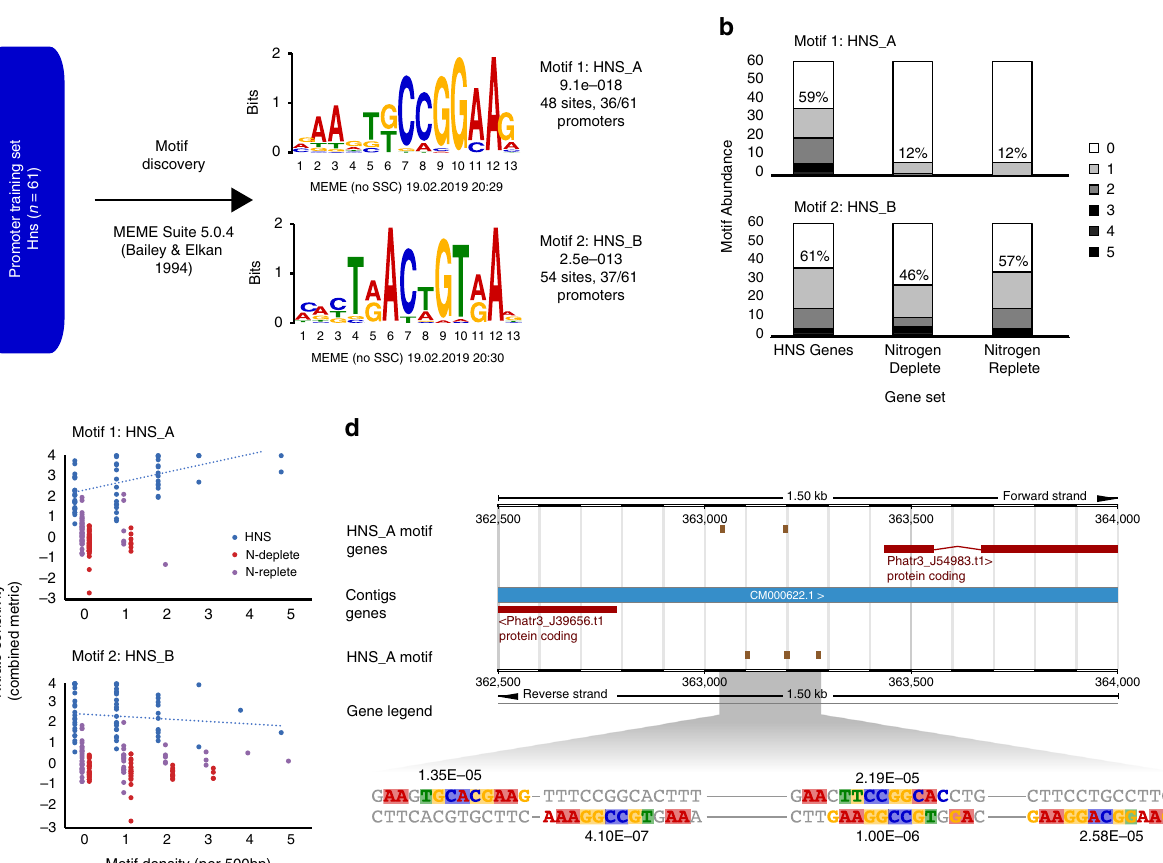
Fig. 3 Transcription factor-binding site identi fi cation in highly nitrate-sensitive genes. a Identi fi cation of motifs detected using promoters (500 bp upstream of ORF) of the HNS genes as a training set E value (MEME) is shown. b Motif abundance in HNS promoters and promoters of nitrogen-deplete and -replete response types (RT184 and RT102). For RT184 and RT102, data show percentages from randomly selected subsets ( n = 61 genes each RT). c